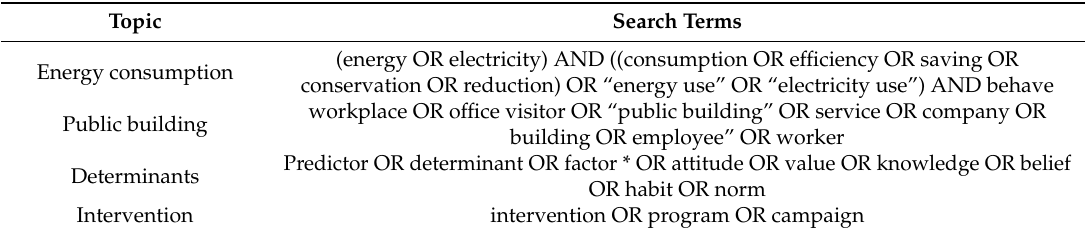
Table 1. Search terms used in the literature review of determinants of energy consumption in public